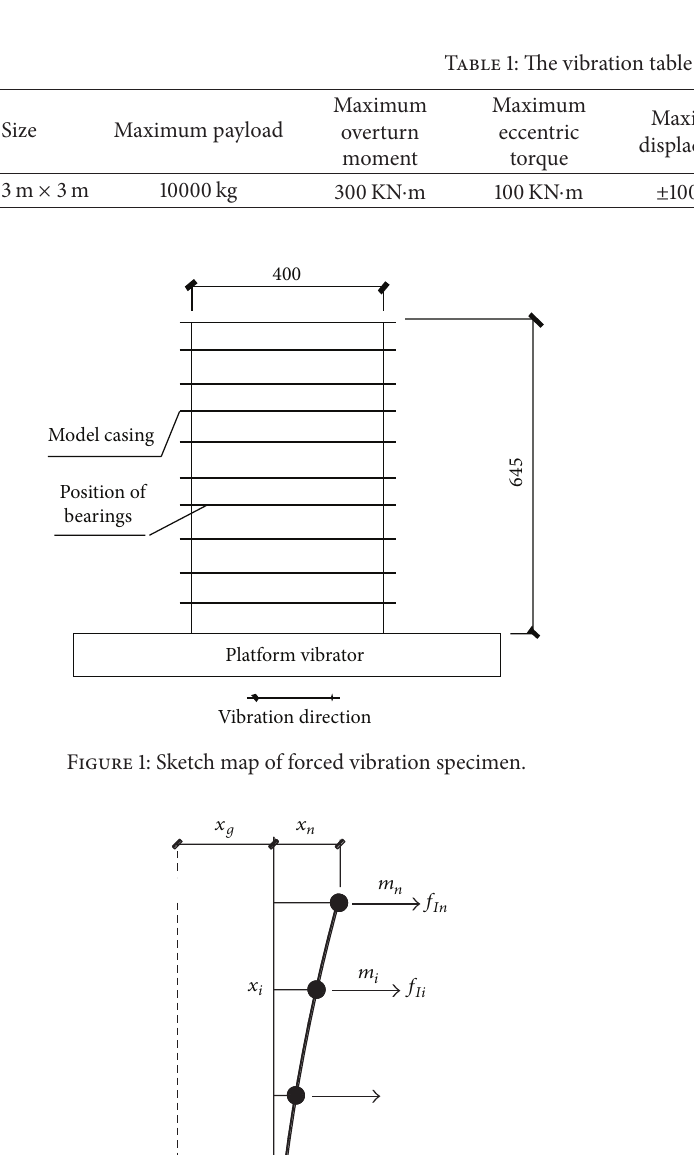
Table 2: Material and mixing